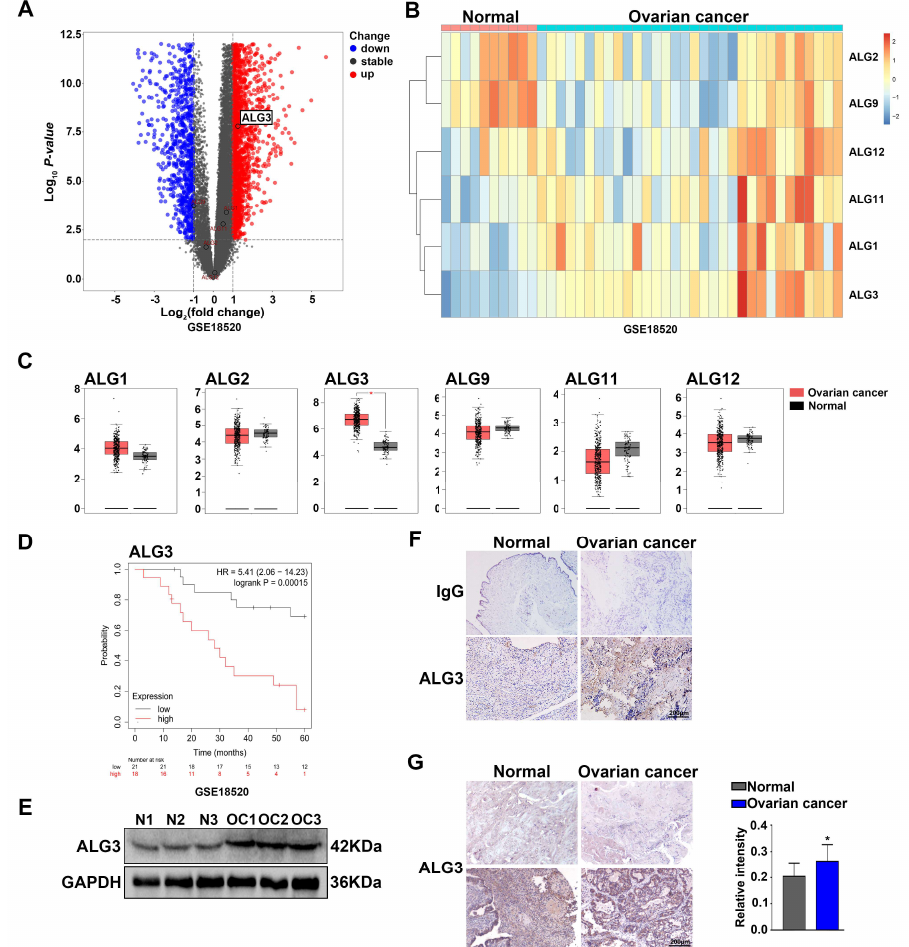
Figure 2. The expression level of ALG3 is upregulated in ovarian cancer tissues. ( A , B ) Volcano plot and heatmap of the mannosyltransferase gene ( ALGs ) in normal ovarian and ovarian cancer tissues from the GEO database (GSE18520, N = 10, OC = 32). ( C ) Differentially expressed genes (DEGs) of ALGs in the normal ovary and ovarian cancer from the TCGA database (N = 88, OC = 426). ( D ) Association between ALG3 mRNA expression and prognosis in ovarian cancer patients using the Kaplan-Meier plotter. ( E ) Detection of the ALG3 level in normal ovarian (N1–N3) and ovarian cancer (OC1–OC3) tissues by Western blot. ( F , G ) Detection of ALG3 expression in normal ovary and ovarian cancer slides and tissue microarrays by immunohistochemistry. Statistical analysis of the relative intensity of the normal ovarian tissue microarray vs. the ovarian cancer tissue microarray. The bar represents 200 μm or 50 μm. * p < 0.05.